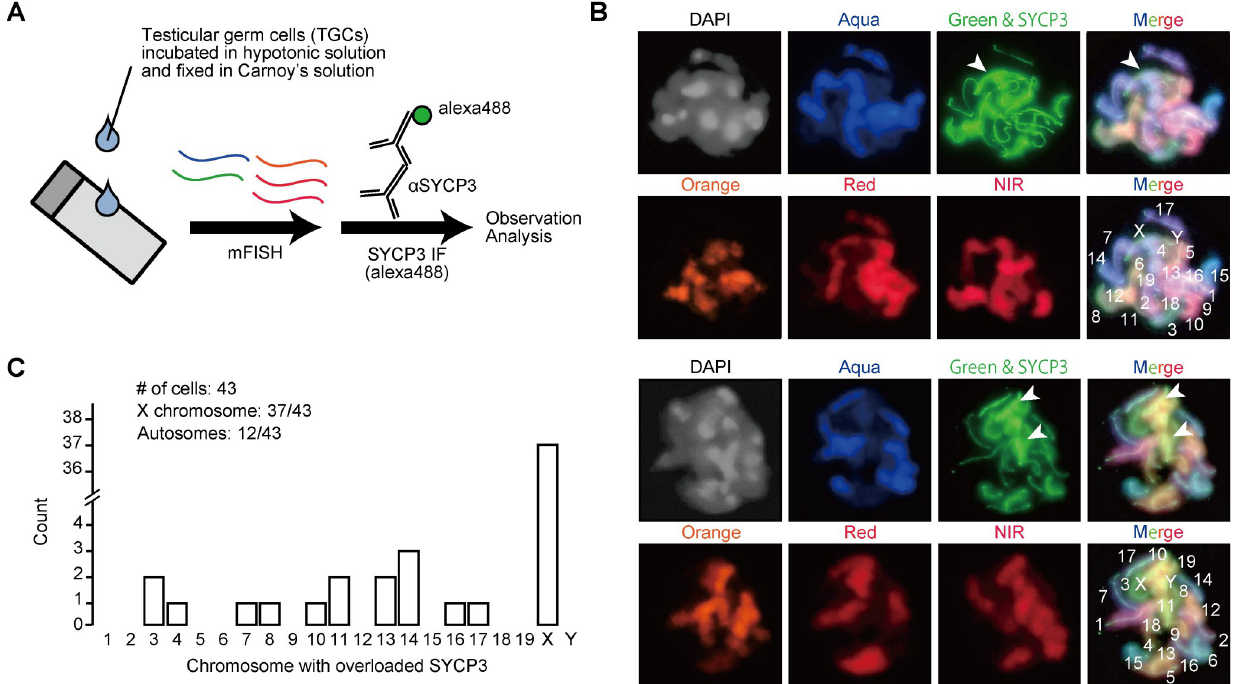
Fig 4. Cytological analysis of Trim41 KO spermatocytes. (A) Schematic of multicolor FISH followed by SYCP3 immunostaining. (B) Pachytene stage spermatocytes were subjected to a multicolor FISH protocol shown in A. Green FISH probe and Alexa-488 are detected by the same filter. White arrowheads indicate overloaded SYCP3 signals. (C) The histogram for the chromosome distribution of SYCP3 overloading. Forty-three well-spread cells were analyzed.